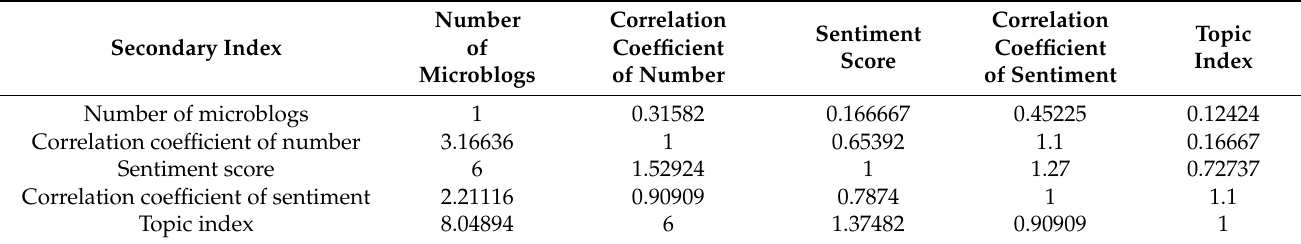
Table 9. Secondary index judgment matrix